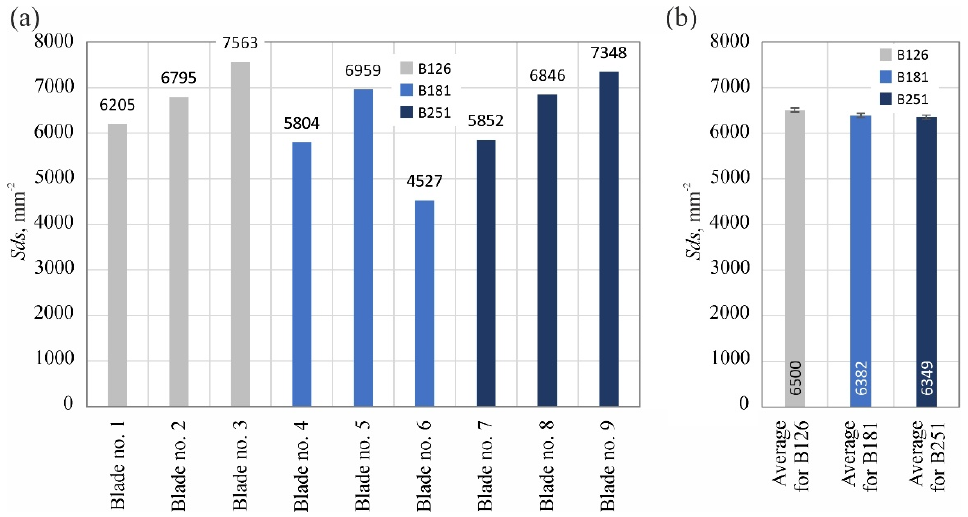
Figure 14. Changes in the density of summits of the surface Sds : ( a ) results for nine blades selected for surface texture measurements; ( b ) average values determined by the size of the cBN abrasive grain of the grinding wheel used (error bars represent the standard error equal to the standard deviation σ divided by the square root of the total number of samples).